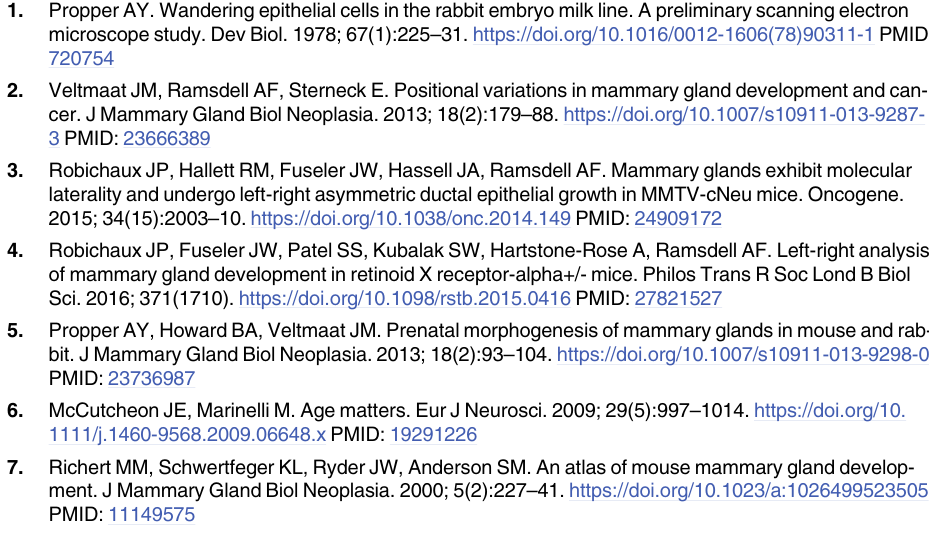
S10 Table. Reactome pathways significantly downregulated in the thoracic mammary glands regardless of dietary exposure. S11 Table. Animal numbers and mammary gland used for analysis. (XLSX) S12 Table. Genes that were determined to be stably expressed in all samples. (XLSX) S13 Table. Primer pairs used in qRT-PCR verification.